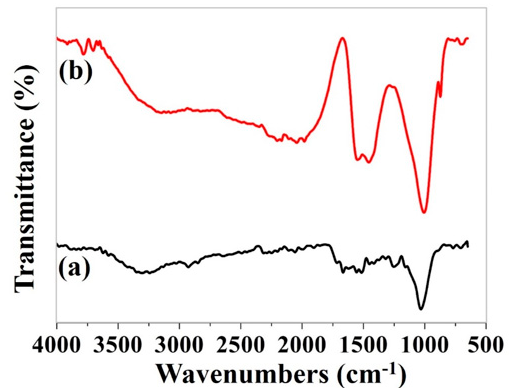
Figure 3. FTIR spectra of ( a ) raw date palm fibre (DPF) before activation and ( b ) bio-powder activated carbon (bio-PAC) after activation.